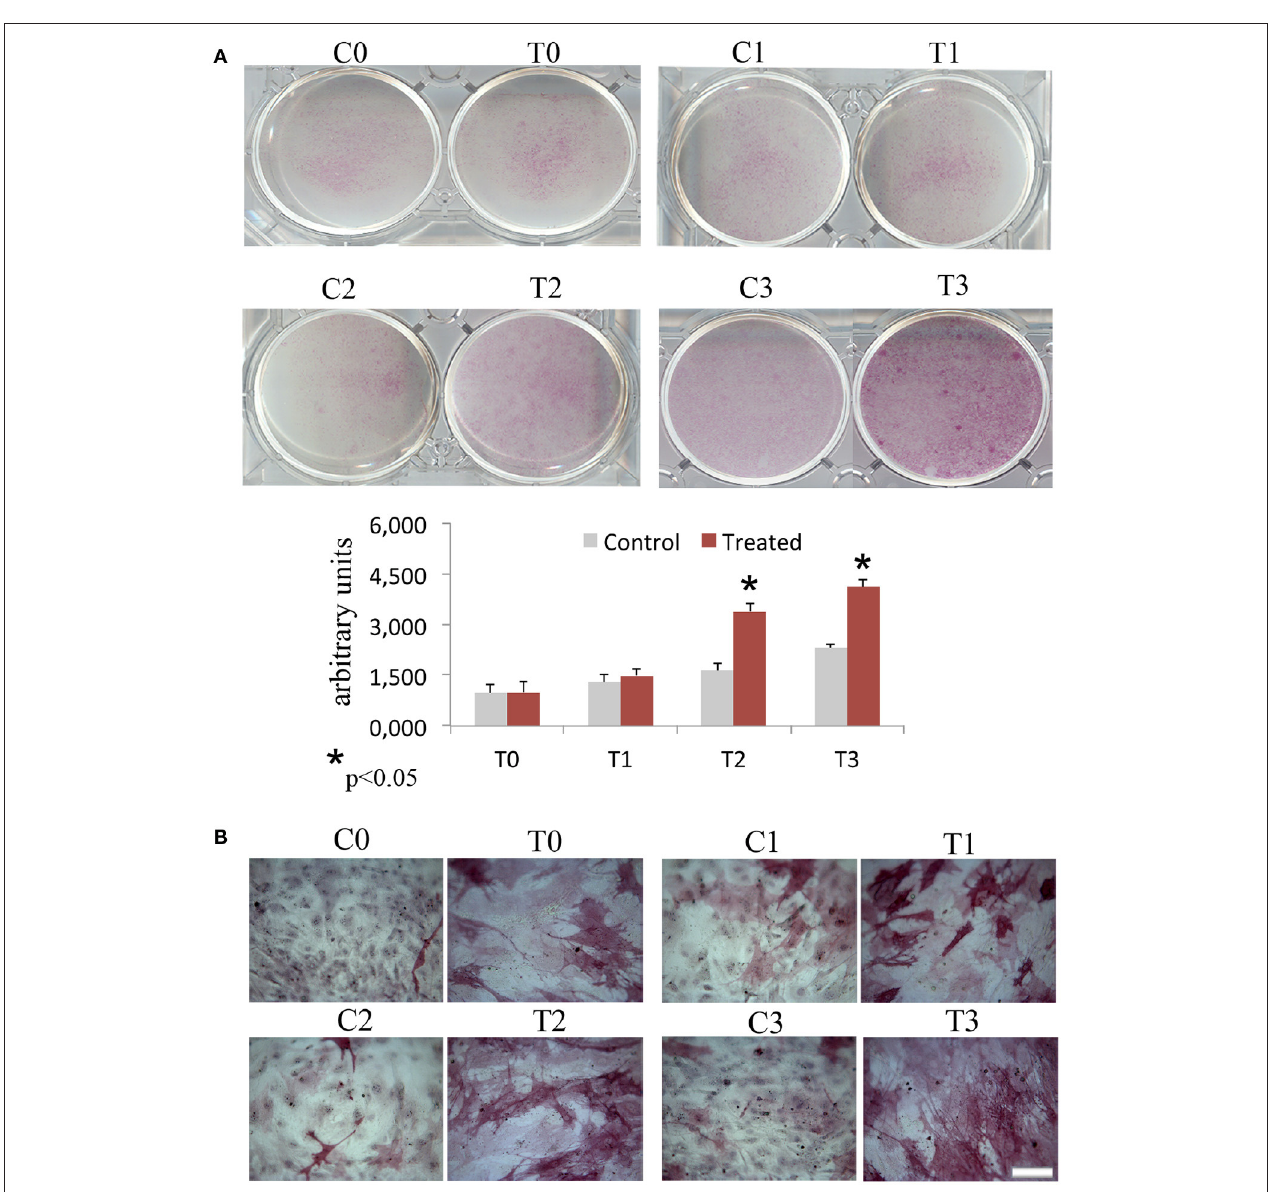
FIGURE 2 | Time-course effects of laser irradiation on ALP activity. BMSCs grown in osteogenic medium, as detailed in Materials and Methods section, was laser irradiated over different periods of time (Day 0: T0; 5 days: T1; 10 days: T2; 15 days: T3). Control cultures (Day 0: C0; 5 days: C1; 10 days: C2; 15 days: C3) were maintained in identical conditions except that the laser device was switched off. At the end of each treatment, colony area was measured by NIH Image both in cultures laser irradiated and in the untreated ones. The values are reported as means ± SD and statistically analyzed; * p < 0.05. vs. the corresponding untreated BMSCs (A) were in accordance with ALP staining observed with a light microscope. Bar, 100 µ m (B) .